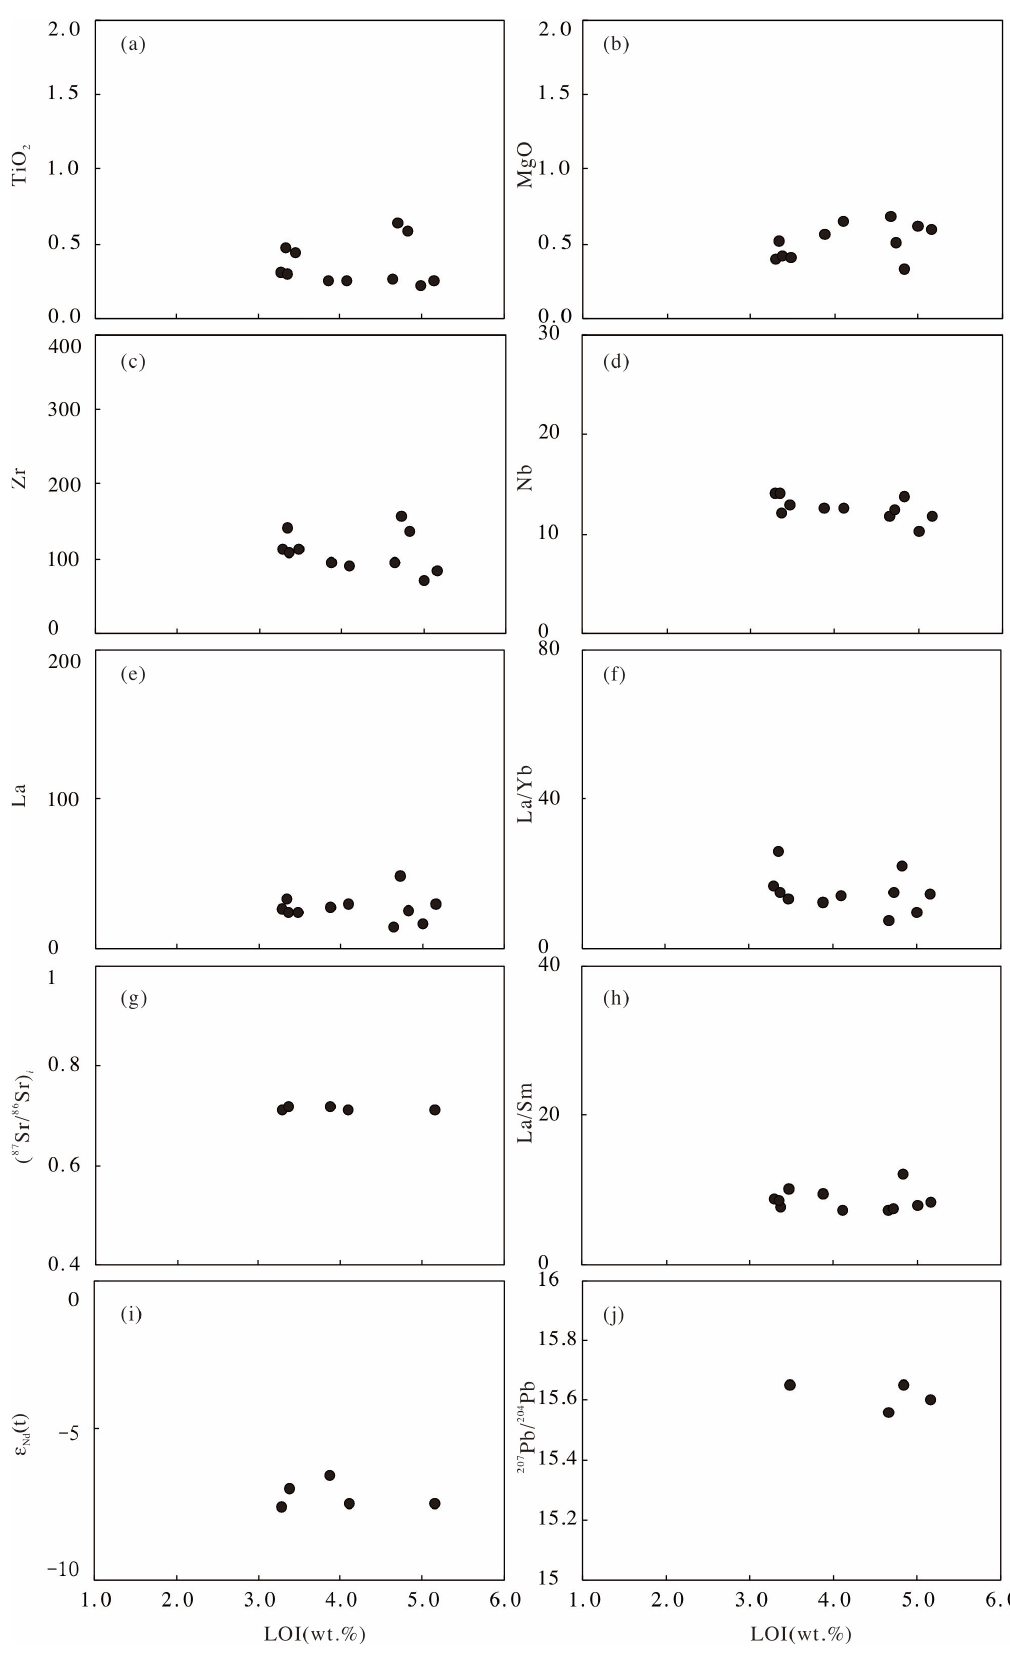
Figure 7. Loss on ignition (LOI) versus TiO 2 ( a ), MgO ( b ), Zr ( c ), Nb ( d ), La ( e ), La/Yb ( f ), ( 87 Sr/ 86 Sr) i ( g ), La/Sm ( h ), ε Nd (t) ( i ), and 207 Pb/ 204 Pb ( j ) for the Dongxiang granodiorite porphyry.